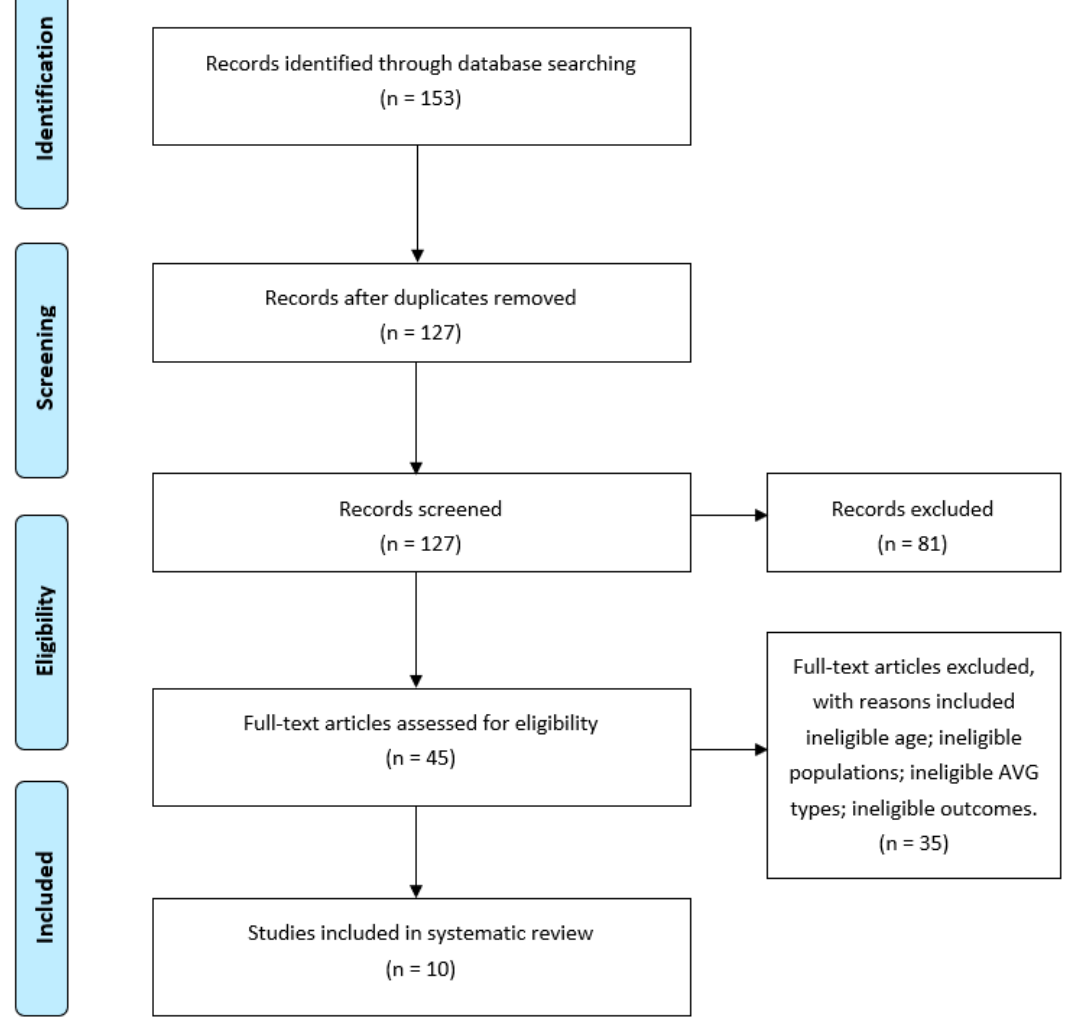
Figure 1. Flow diagram of studies through the review process.